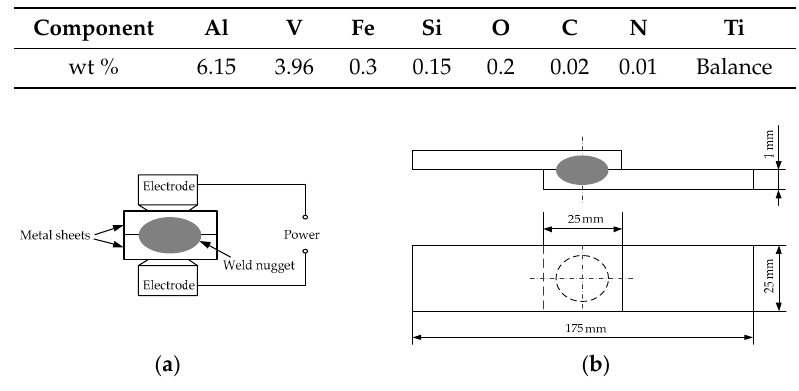
Figure 1. ( a ) Schematic diagram of resistance spot welding process; and ( b ) configuration and dimensions of specimen.